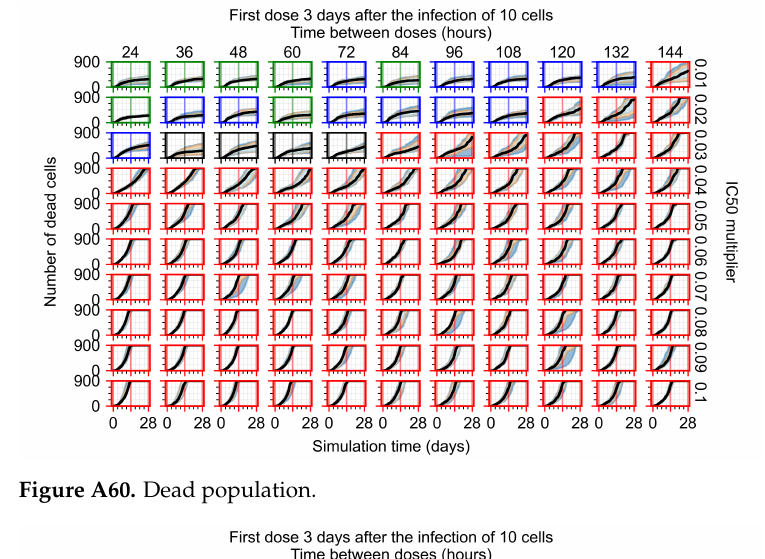
Figure A59. Infected (secreting extracellular virus) population.